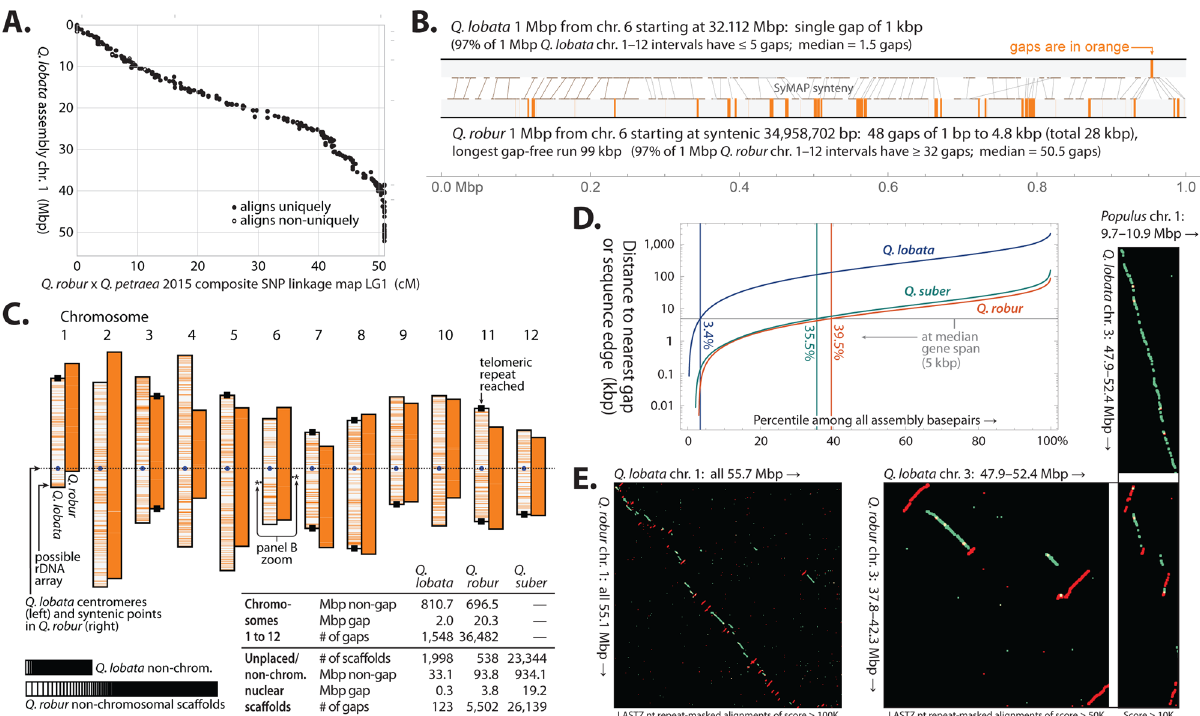
Fig. 1 Overview of assemblies of Q. lobata tree SW786 (version 3.0), Q. robur (version PM1N) 6 , and Q. suber (version 1.0) 12 . A Alignment of a linkage map linkage group 1 to Q. lobata chr. 1, exhibiting high concordance and overall monotonicity. B A representative 1 Mbp region from the Q. lobata assembly (top) and the syntenic 1 Mbp region from the Q. robur assembly (bottom), showing gaps in orange. C Overview of the chromosome-level assemblies ( Q. lobata left member of each pair, Q. robur right) with orange lines indicating gaps, and basic statistics for all three assemblies. D Distributions of distance from a random base pair to the nearest gap or sequence edge. E Nucleotide alignments of entire chr. 1 of Q. lobata and Q. robur , showing numerous apparent rearrangements and inversions, in contrast to a more detailed illustrative region between chr. 3 of the two Quercus with chr. 1 of more distant Populus trichocarpa 20 , in which the Q. lobata assembly is straight-line syntenic with Populus but that of Q. robur is not. Alignments between nominal same/ opposite strands are colored